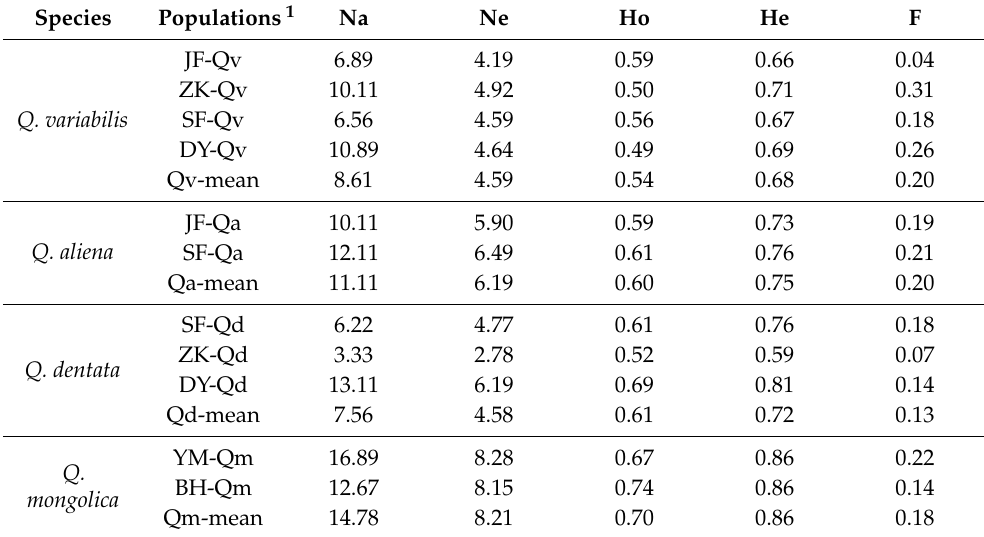
Table 1. Genetic variation of different oak populations. Species Populations 1 Na